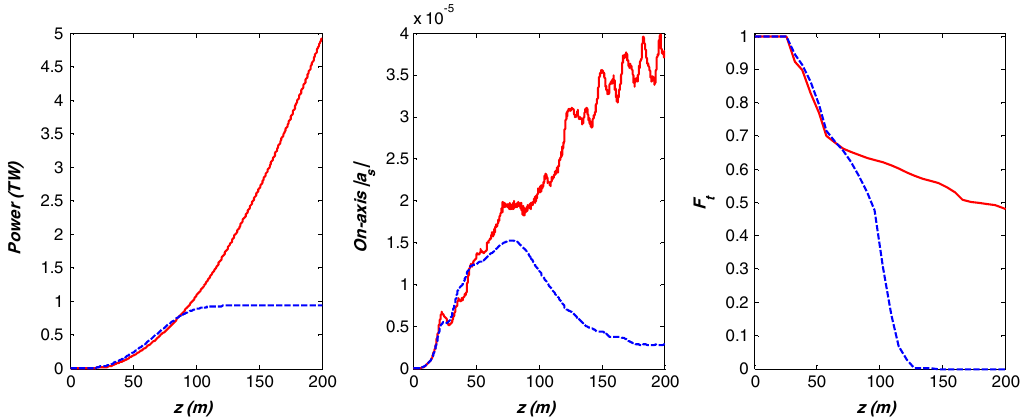
j and F in a 200-m, hard x-ray, tapered FEL without break s t